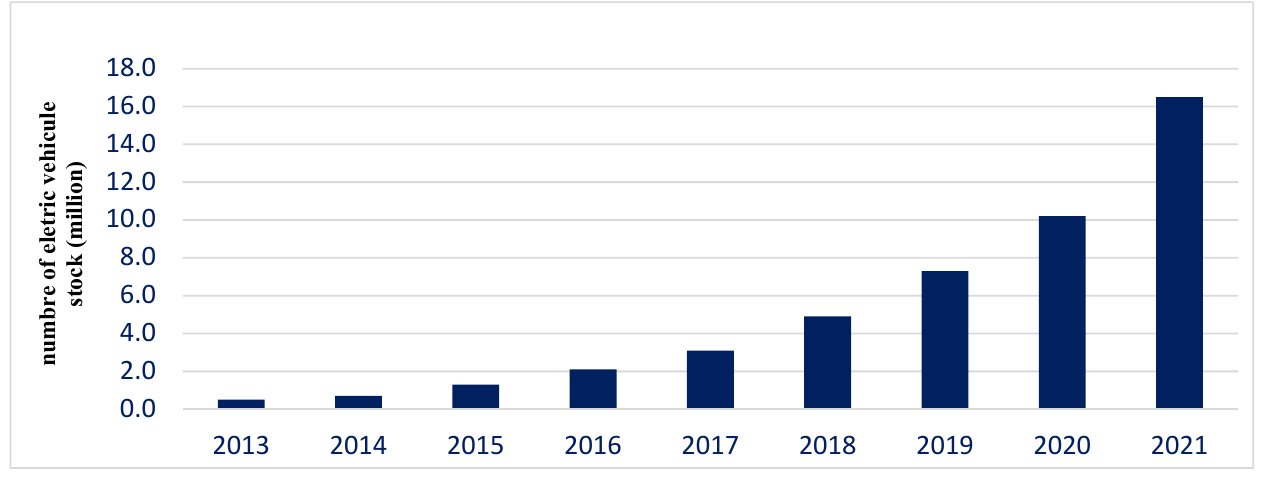
Figure 1 . Evolution of global EV. Figure 1. Evolution of global